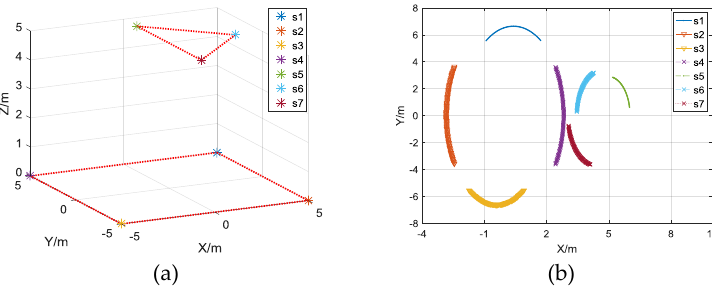
Figure 6. The model of the simulated target. ( a ) The point-scatterer model. ( b ) The scatterer trajectories.